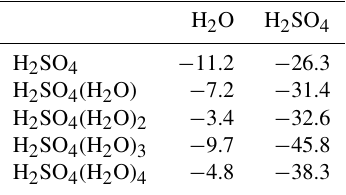
Table 1. Free energies (in kJmol − 1 , at T = 298K and p 0 = 1atm) of binary nucleation of H 2 SO 4 (1) and H 2 O (2) to small H 2 SO 4 (H 2 O) n clusters calculated at the M06-2X/aug-cc-pVDZ level of theory. H 2 O H 2 SO 4